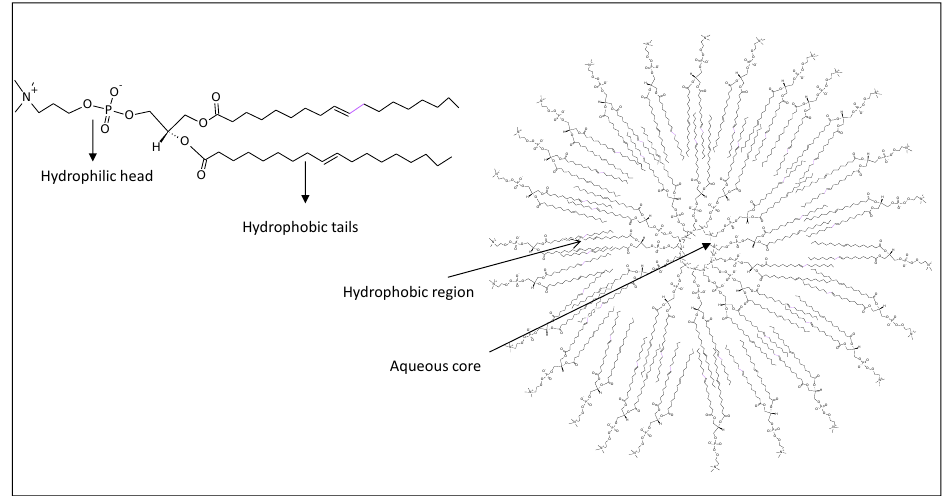
Figure 1. Schematic representation of liposome (right). Chemical structure of a generic phospholipid used to prepare the liposome (left).